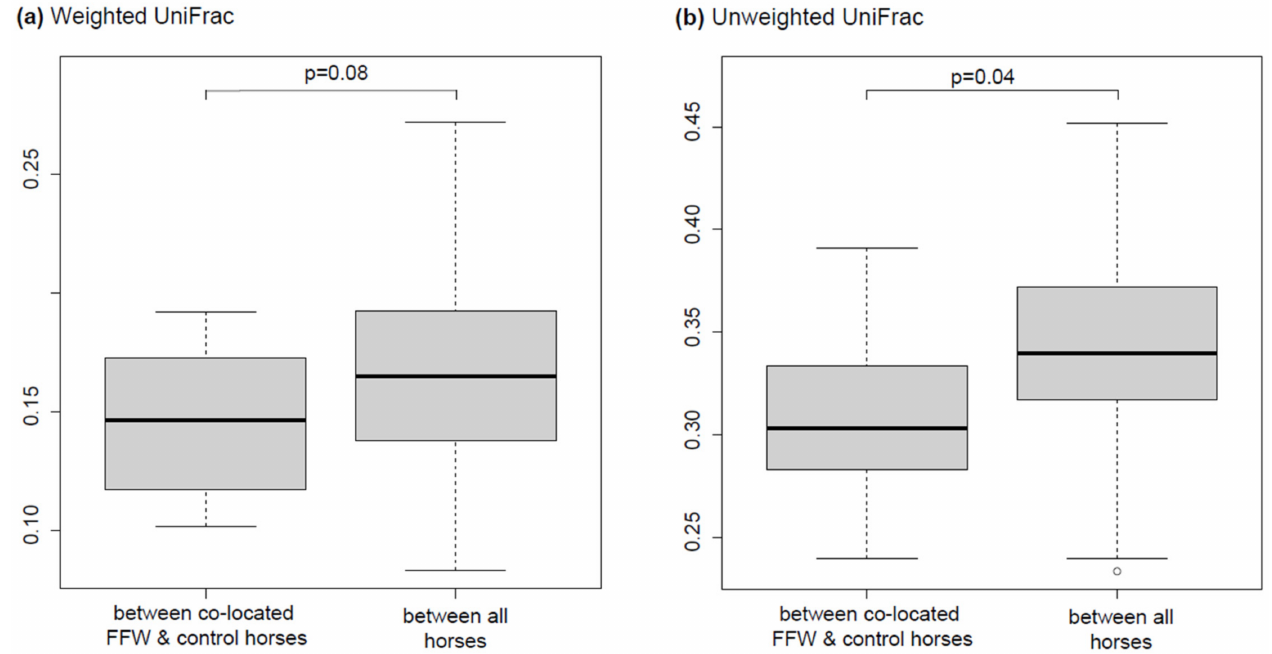
Figure 4. Boxplots of the weighted ( a ) and unweighted ( b ) UniFrac distances between co-located FFW and control horses and all horses are shown. A distance of 0 indicates the samples are identical, and higher values (up to a maximum of 1) indicate the extent of differences between compared samples. Boxes show the 25th and 75th percentiles with the median represented by a horizontal line. Whiskers show the data range, with the exception of one outlier, which is indicated by a data